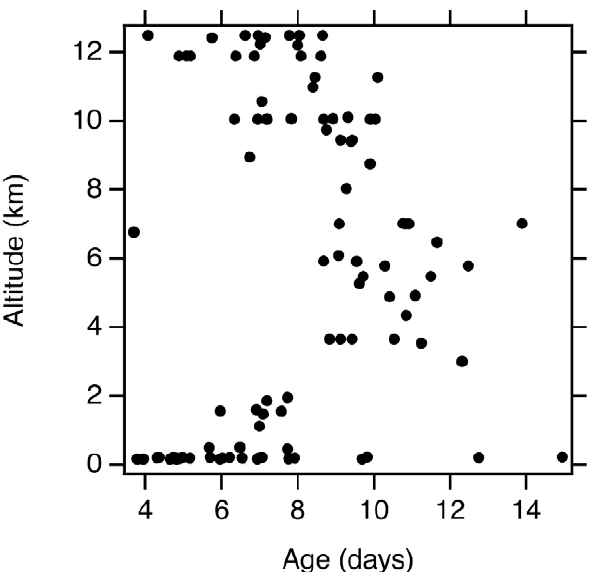
Fig. 23. Altitude profile of the estimated age of sampled pollution during INDOEX (from de Gouw et al., 2001, copyright 2001 by the American Geophysical Union, reproduced with